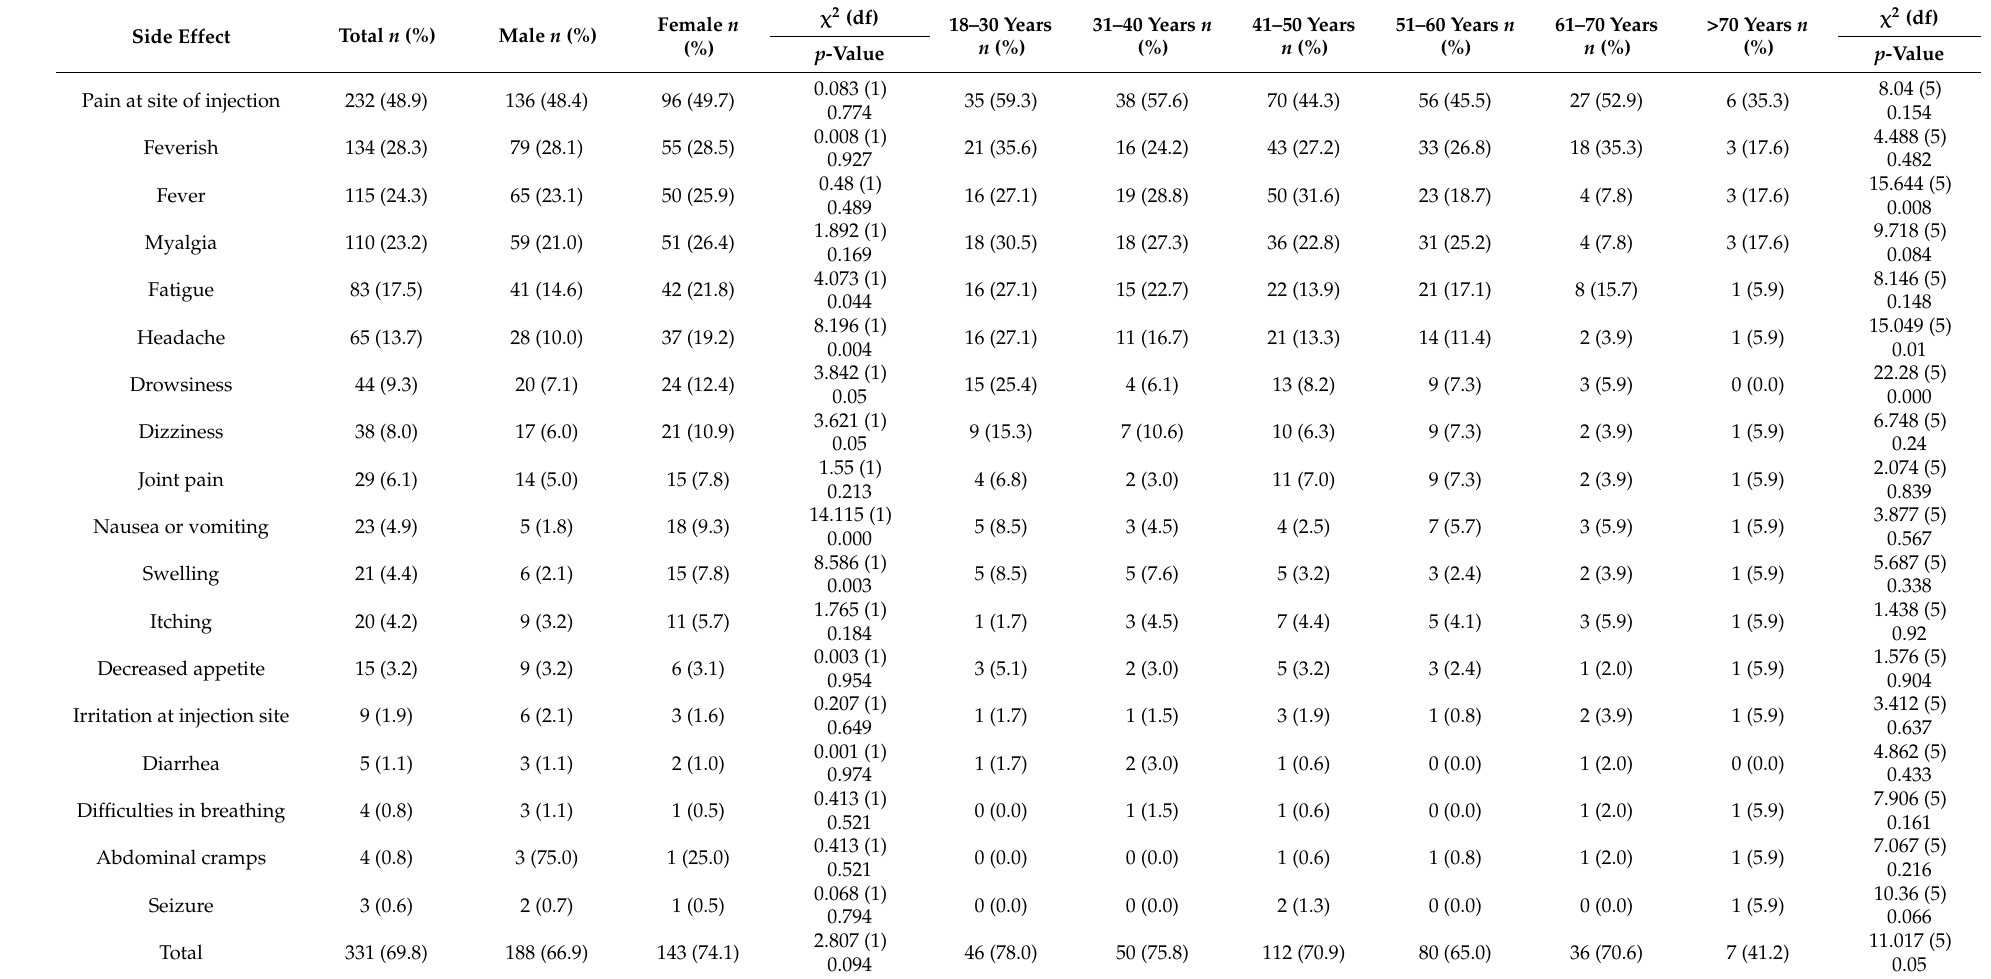
Table 3. Association of individual post-vaccination side effects with gender and different age